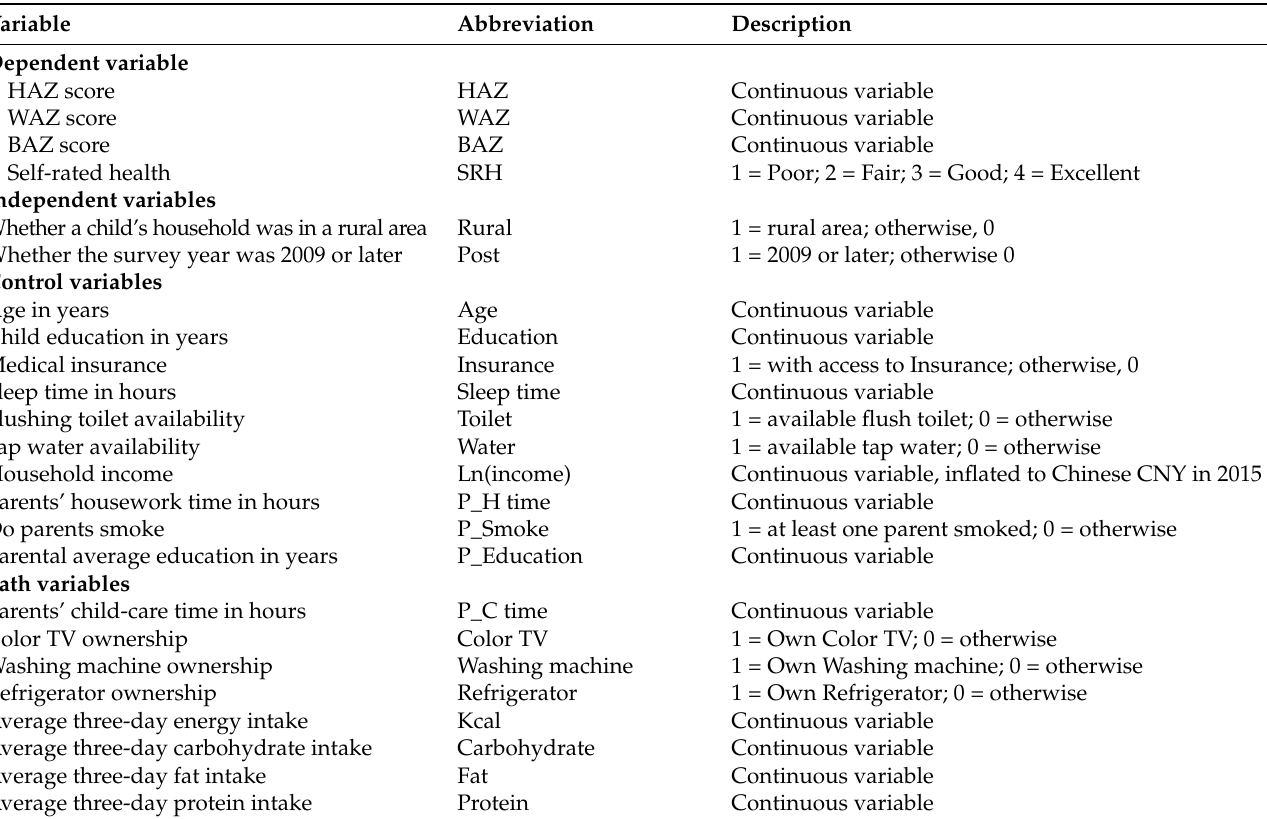
Table 1. Variables and